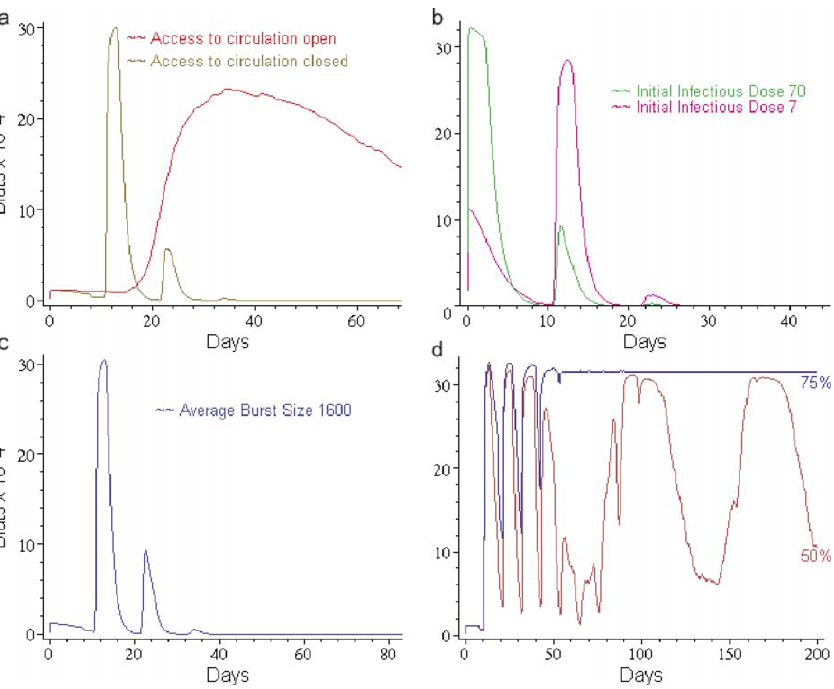
Figure 5. Access to the Peripheral Circulation Is Required for Viral Persistence in the Simulation (A) The virtual virus does not persist when latently infected virtual B cells (B Lat ) are denied access to the peripheral circulation. The graph shows the level of B Lat s over time for a simulation run with the default parameter set allowing (red line) or denying (brown line) access of the B Lat s to the peripheral circulation Note that only the first 60 d of virtual infection are shown. A characteristic series of spikes in B Lat s is observed that was lost after approximately 30–40 d. These spikes arise because normally B Lat s spend time in the circulation, and the time they spend there does not advance them towards the lytic state. By denying them access to the blood, both the mean time to burst and the standard deviation of this statistic decrease. This causes the virtual viral bursts and infection of new virtual B cells to arrive synchronously as narrow spikes, one spike per generation of infected virtual cells. (B) Increasing the initial infectious dose does not allow persistence in the absence of a peripheral blood compartment. The simulation was run without a peripheral blood compartment as described in (A), except the initial infectious dose was increased in increments as shown. The initial infectious dose is the average number of Vir deposited at each mesh point (node) on the surface of the virtual lymphoepithelium. To obtain the total infectious dose, this value is multiplied by the number of surface nodes (16,205). The figure shows runs with infectious dose of 7/mesh point (pink line) and 70/mesh point (green line). The default value for initial infectious dose is 0.7/mesh point. (C) Increasing the Vir burst size does not allow persistence in the absence of a peripheral blood compartment. The simulation was run without a peripheral blood compartment as described in (A), except the number of Virs released when a B Lyt bursts was doubled (default average burst size ¼ 800 Virs). (D) Decreasing the efficiency of the immune response does not allow persistence in the absence of a peripheral blood compartment. The simulation was run without a peripheral blood compartment as described in (A), except the efficiency with which CTLs are activated and kill their targets was reduced incrementally. With this approach it was possible to find a level of virtual immunosuppression (50% brown line) that produced an infection that lasted for the length of the simulation (880 virtual days). However, this looks nothing like EBV persistence in a real infection. Rather, the virtual infection involves wild oscillations in the number of latently infected virtual B cells (B Lat ) and it appears that the average level is trending upwards to overwhelm the B cell compartment, a condition we refer to as virtual death. Small incremental increases above 50% immunosuppression (e.g., 75% blue line) resulted in the B cell compartment being rapidly overwhelmed with latently infected virtual B cells (B Lat ). Small incremental decreases below